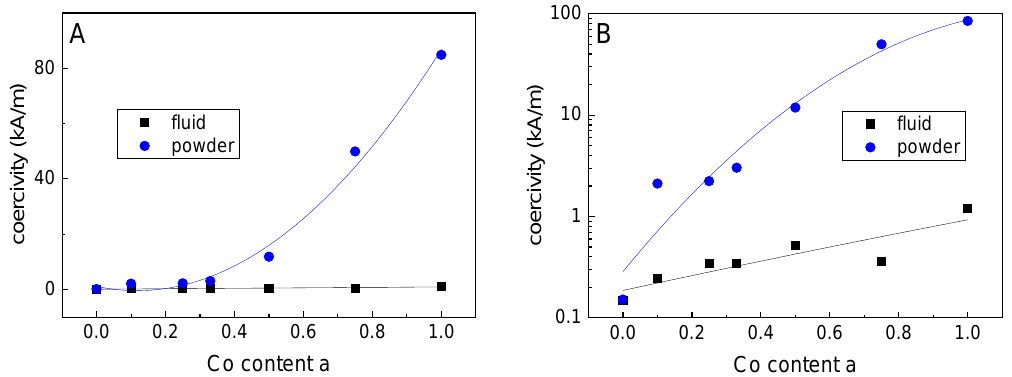
Figure 7. Coercivity of the powder samples (blue spheres) and the fluidic samples (black squares) as a function of the Co content, plotted on ( A ) linear and ( B ) logarithmic scales; the lines serve as a guide to the eye only.